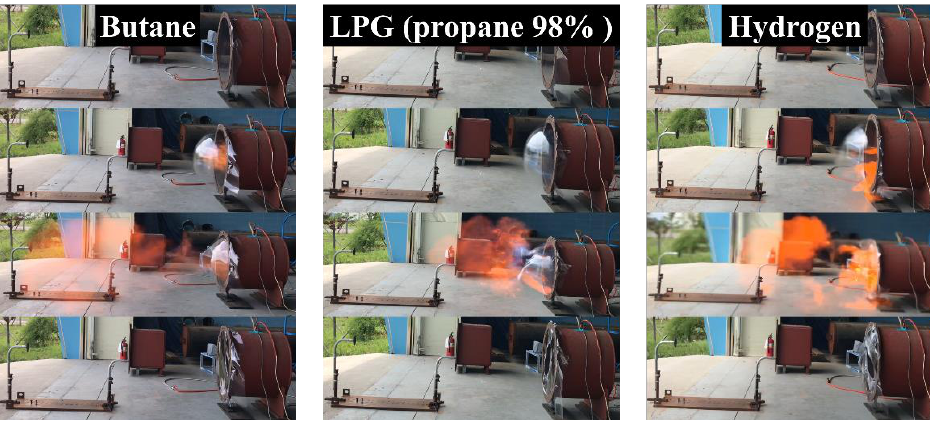
Figure 11. Explosion process in the cylinder-type chamber.